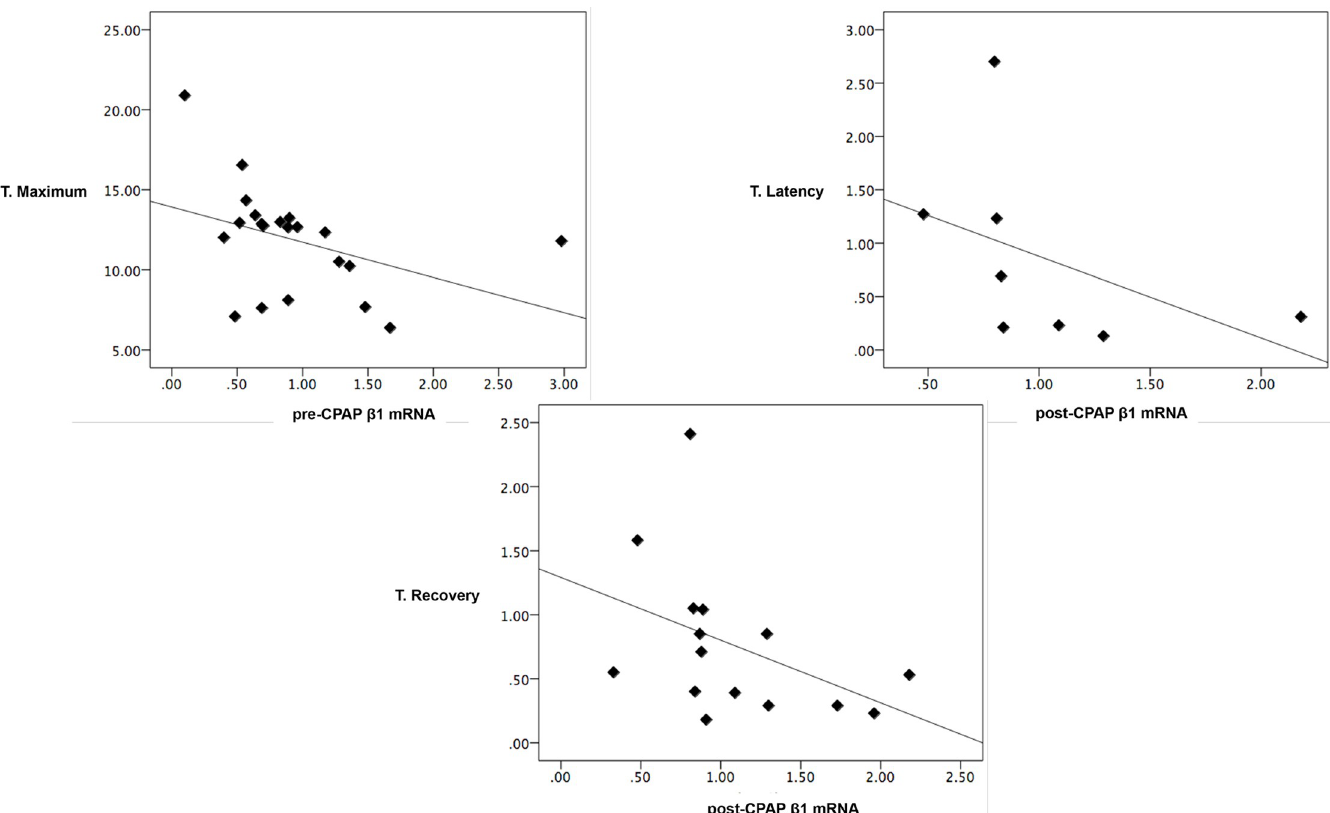
Fig 3. The endothelial function in non-hypertensive OSA patients was significantly correlated with β 1-subunit mRNA expression. T. recovery: time to recovery. T. Latency: time to latency time. T. Maximum: time to maximum flow. pre-CPAP β 1 mRNA: β 1-subunit mRNA expression at baseline. post-CPAP β 1 mRNA: β 1-subunit mRNA expression after 3 months of CPAP treatment. � p <